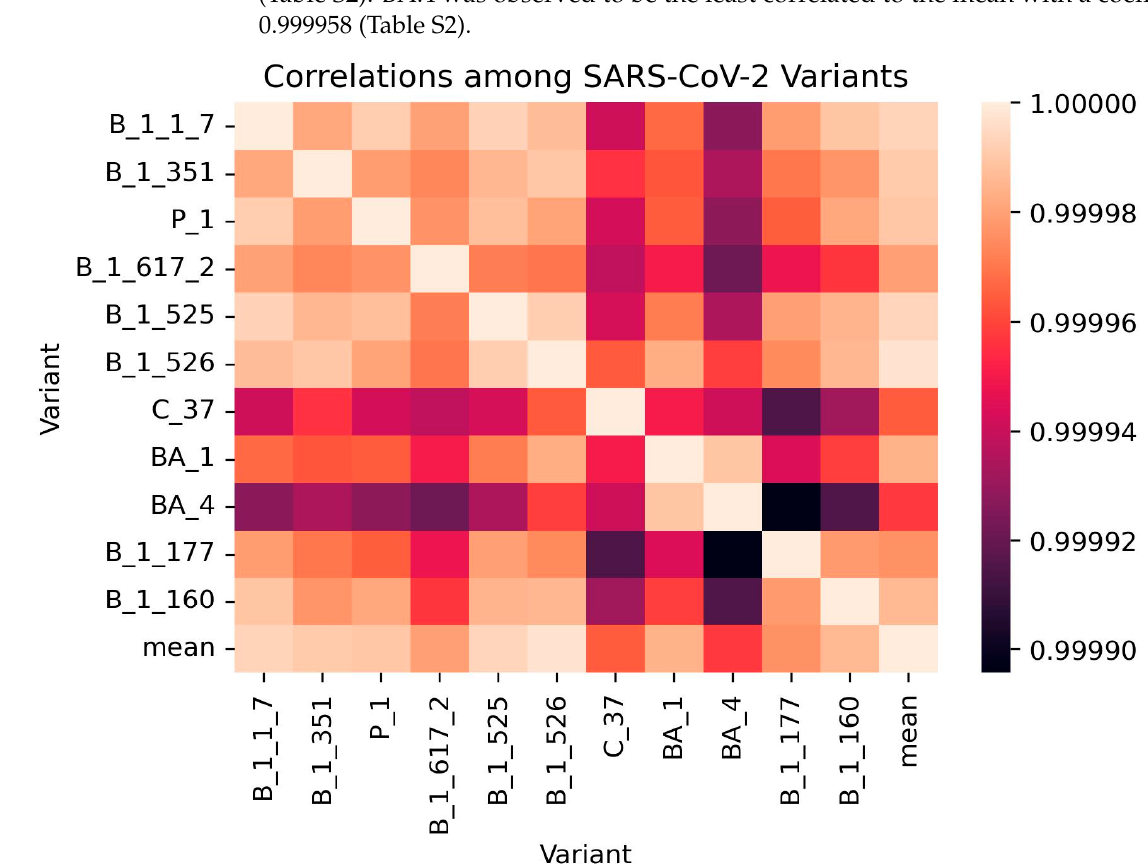
Figure 3. Correlation matrix of the various SARS-CoV-2 variants using their AACs.